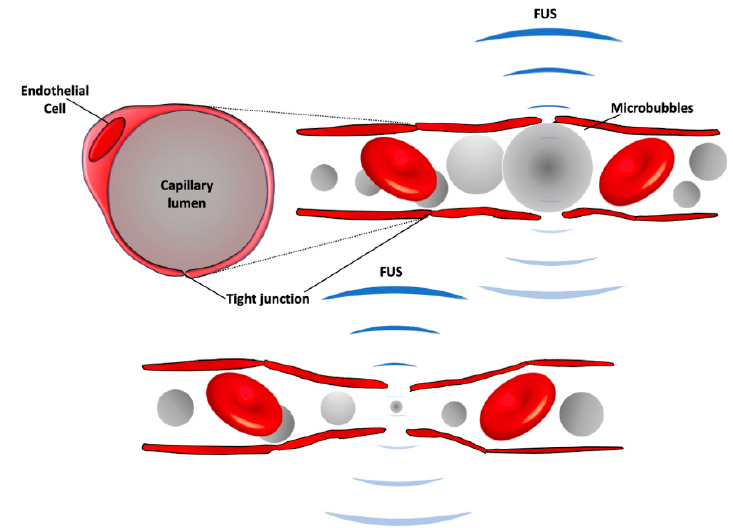
Figure 1. A schematic of BBB modulation following focused ultrasound (FUS) with intravenous injection of microbubbles. Circulating microbubbles expand (top) and contract (bottom) in the acoustic field, stretching the capillary walls and producing forces on endothelial cells to generate bioeffects that increase BBB permeability. The expansion and contraction happen at the frequency of the ultrasound field, which is 220,000 times/s with the clinical system.